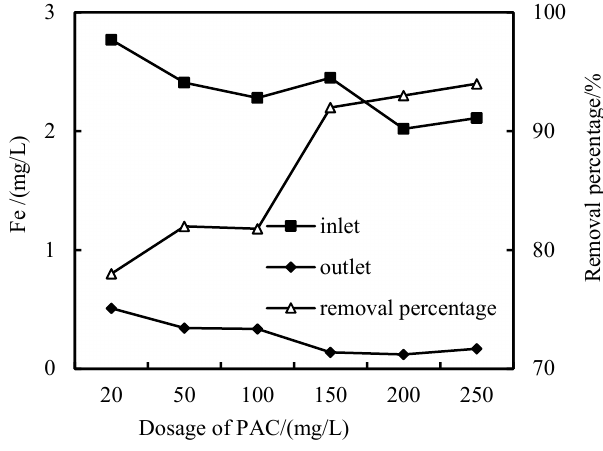
Figure 11. Removal effect of Fe with PAC dosage.